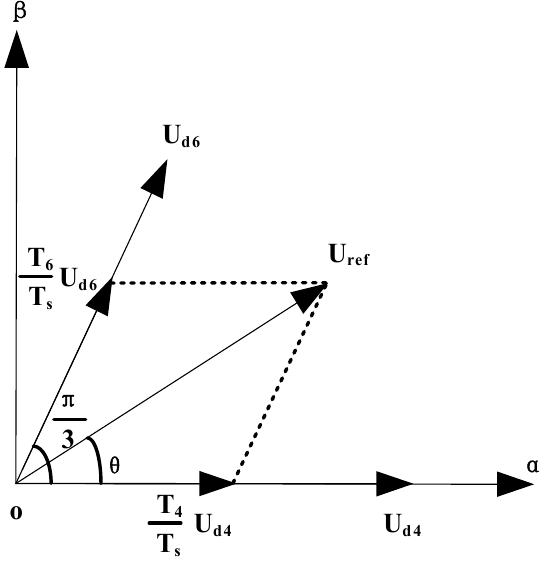
Figure 12. The vector composition in the ( 0 − π /3) region.